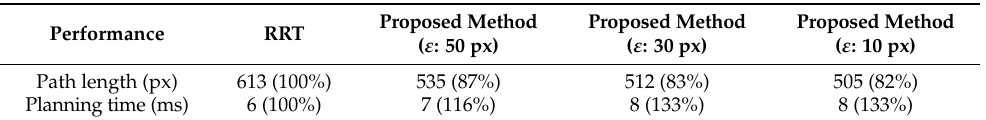
Table 3. Experimental results of Map 2 (numbers in parentheses (averages of repeating trial 100 times) are relative ratios to RRT results (values less than 1 are counted as 1)). Proposed Performance RRT ( ε : 50 px) Path length (px) Planning time (ms) Table 4. Experimental results of Map 3 (numbers in parentheses (averages of repeating 100 times) are relative ratios to the RRT results (values less than 1 are counted as 1)). Proposed Method Proposed Method Proposed Method Performance RRT ( ε : 50 px) ( ε : 30 px) ( ε : 10 px) Path length (px) 613 (100%) 512 (83%) 505 (82%) Planning time (ms)